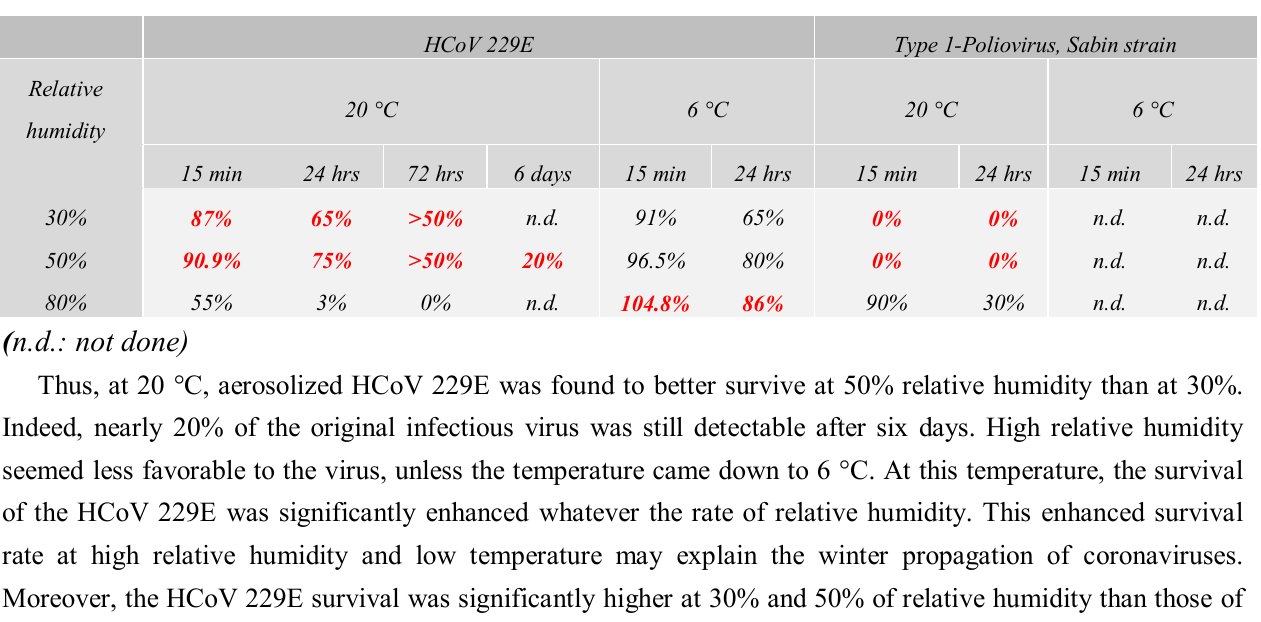
Table 1. Survival rates of the HCoV 229E and the poliovirus, type 1, under different conditions of temperature and humidity